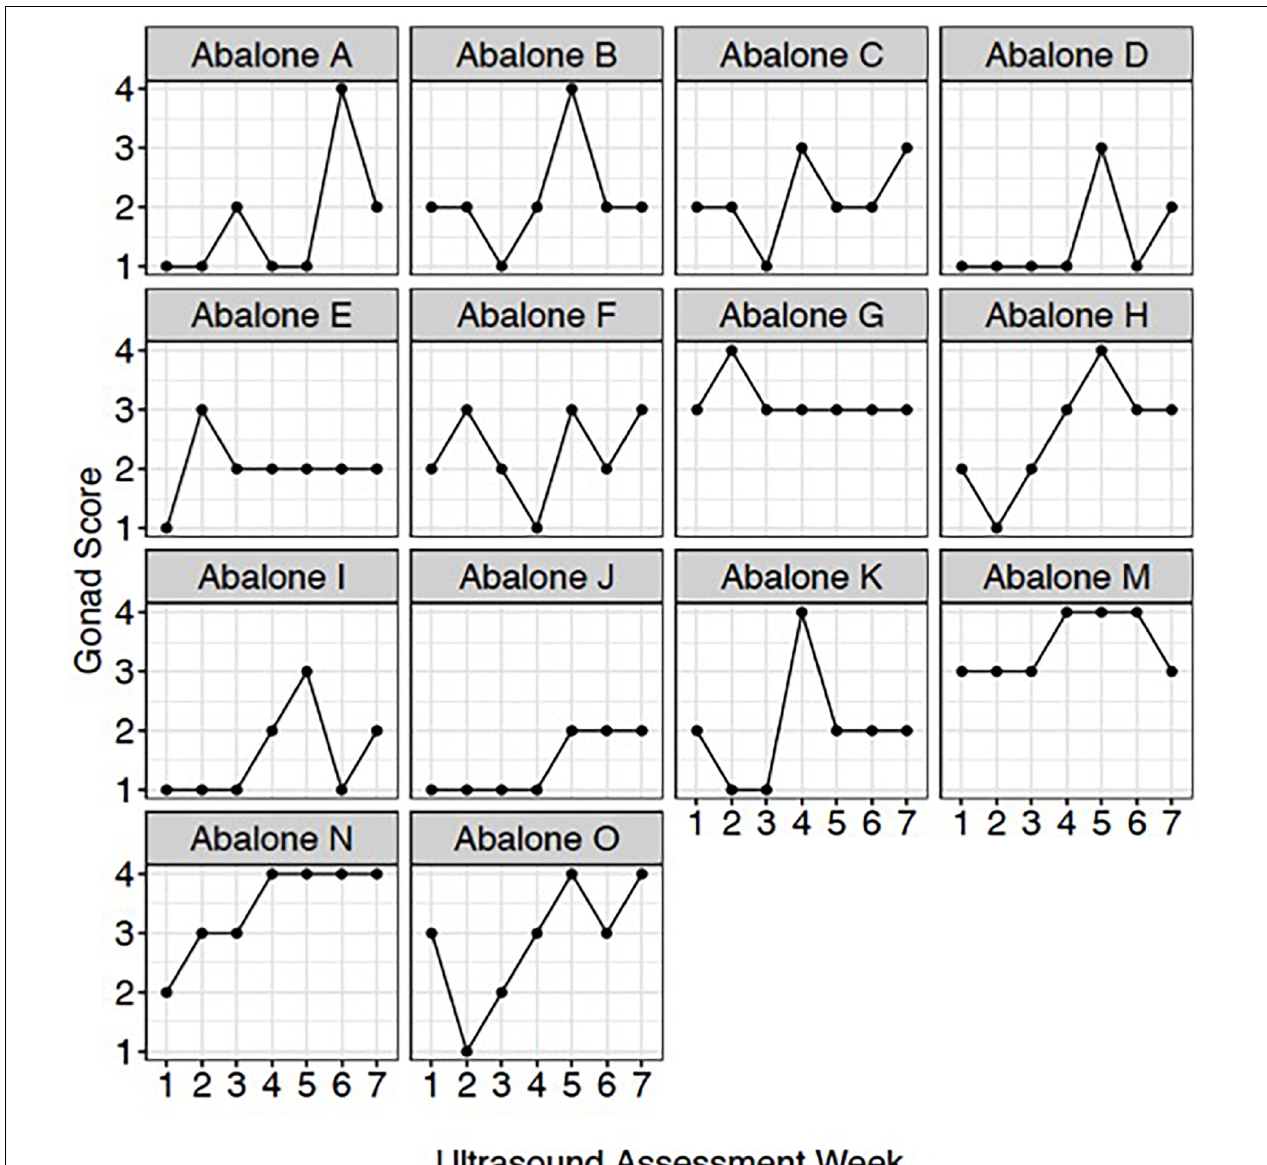
FIGURE 4 | Red abalone ( Haliotis rufescens ) weekly ultrasound gonad scores. Each panel represents an individual abalone’s gonad development across the 7-week assessment